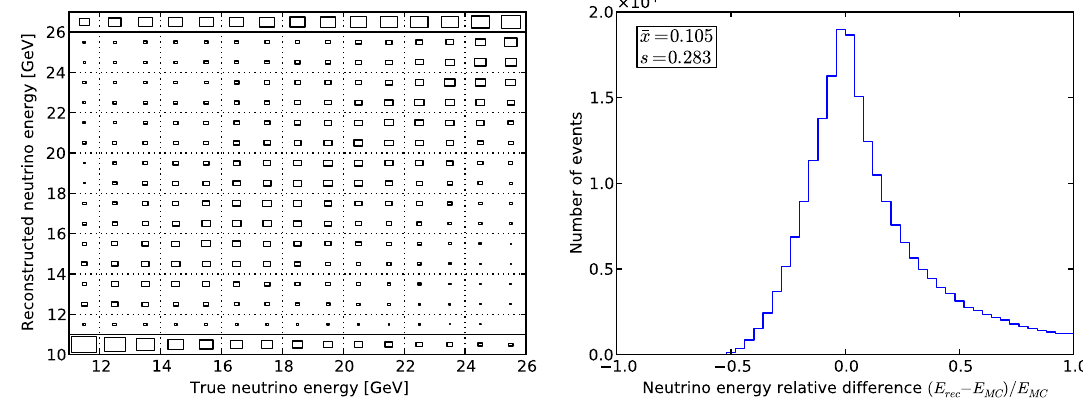
FIG. 14. Naive reconstruction of the neutrino energy using the IMD sample (background excluded). Left—migration matrix (the sum over each column is normalized to unity). The overflow and underflow bins are separated with horizontal lines. Right— relative difference ð E rec (cid:5) (cid:1) E true (cid:5) Þ =E true (cid:5) .